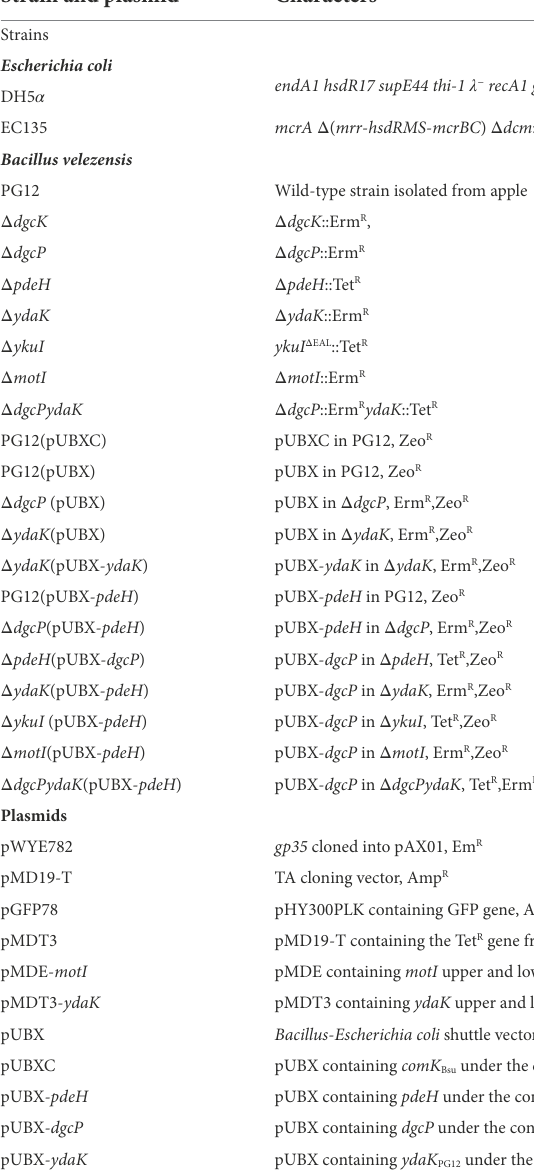
TABLE 1 Strains and plasmids used in this study. Strain and plasmid Characters